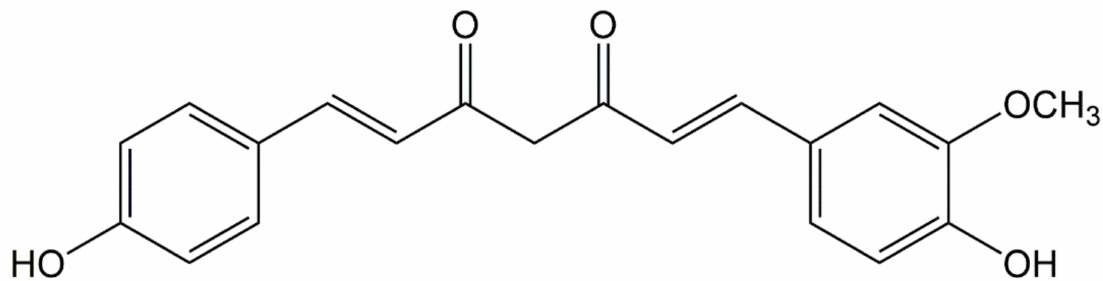
Figure 1. The chemical structure of demethoxycurcumin (DMC).